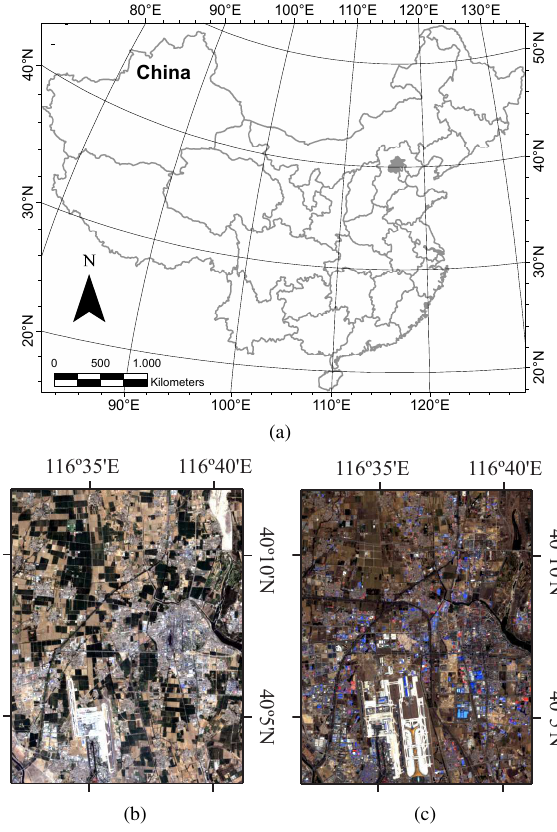
Figure 1: The studied area of China: Map location of the sub- area in a), satellite image acquired on April 30, 2000 in b), and satellite image acquired on April 10, 2010 in c). this work, atmospheric correction has been carried out using the dark substraction algorithm and radiometric correction has been done using the Landsat Correction algorithm of the ENVI soft- ware. The geometric correction is also applied in order to resem- ble the truth ground location coordinates following